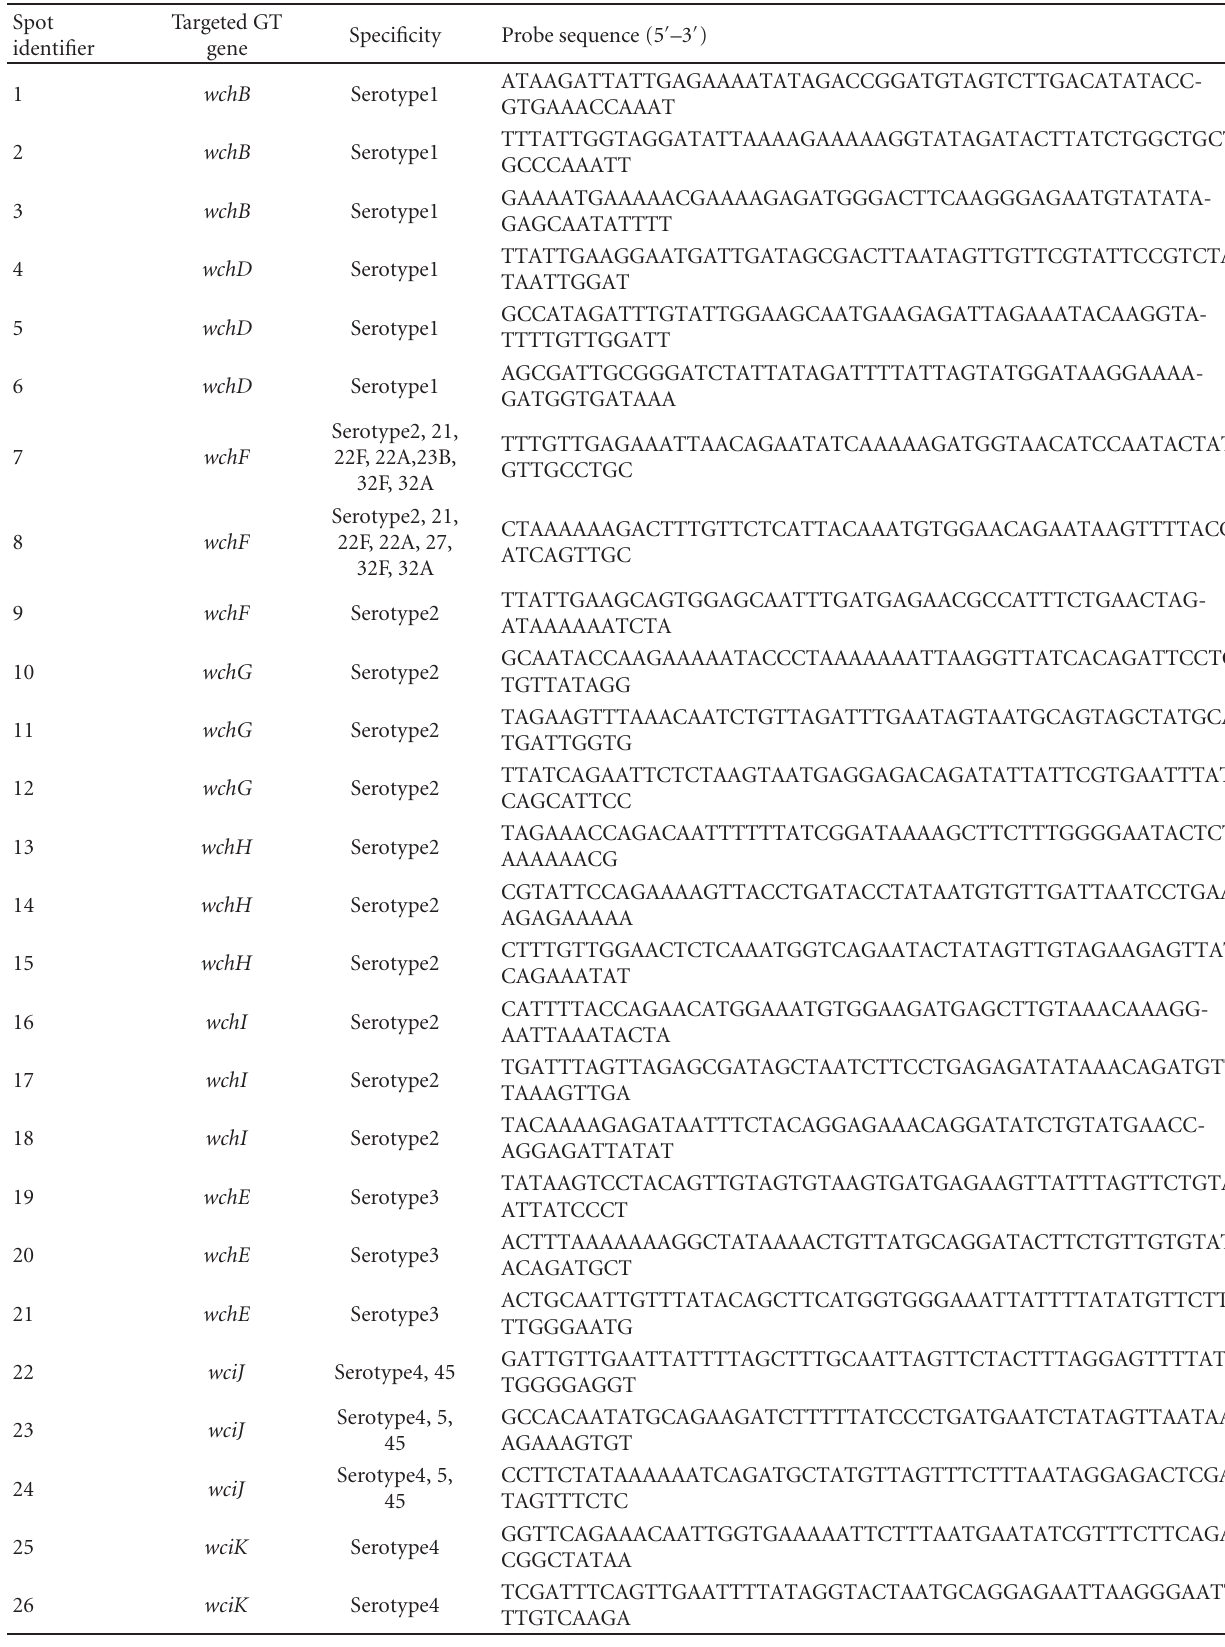
Table 3: Oligonucleotide probes used in this